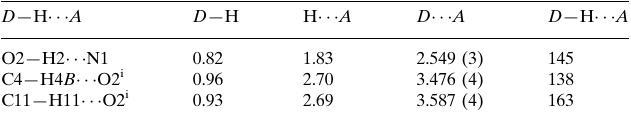
Hydrogen-bond geometry (A˚ , (cid:2)